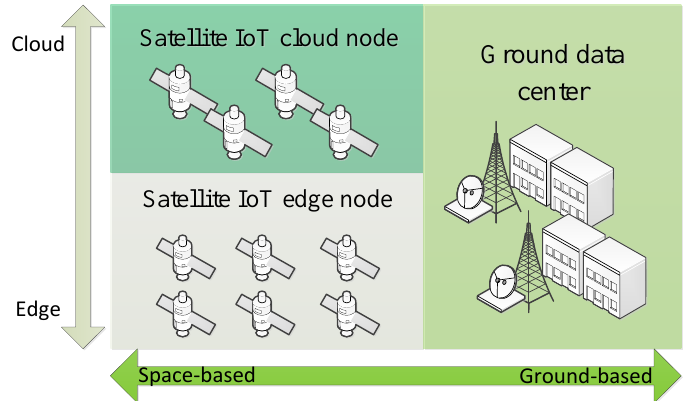
Figure 1. Cloud-edge layered satellite IoT edge computing system.